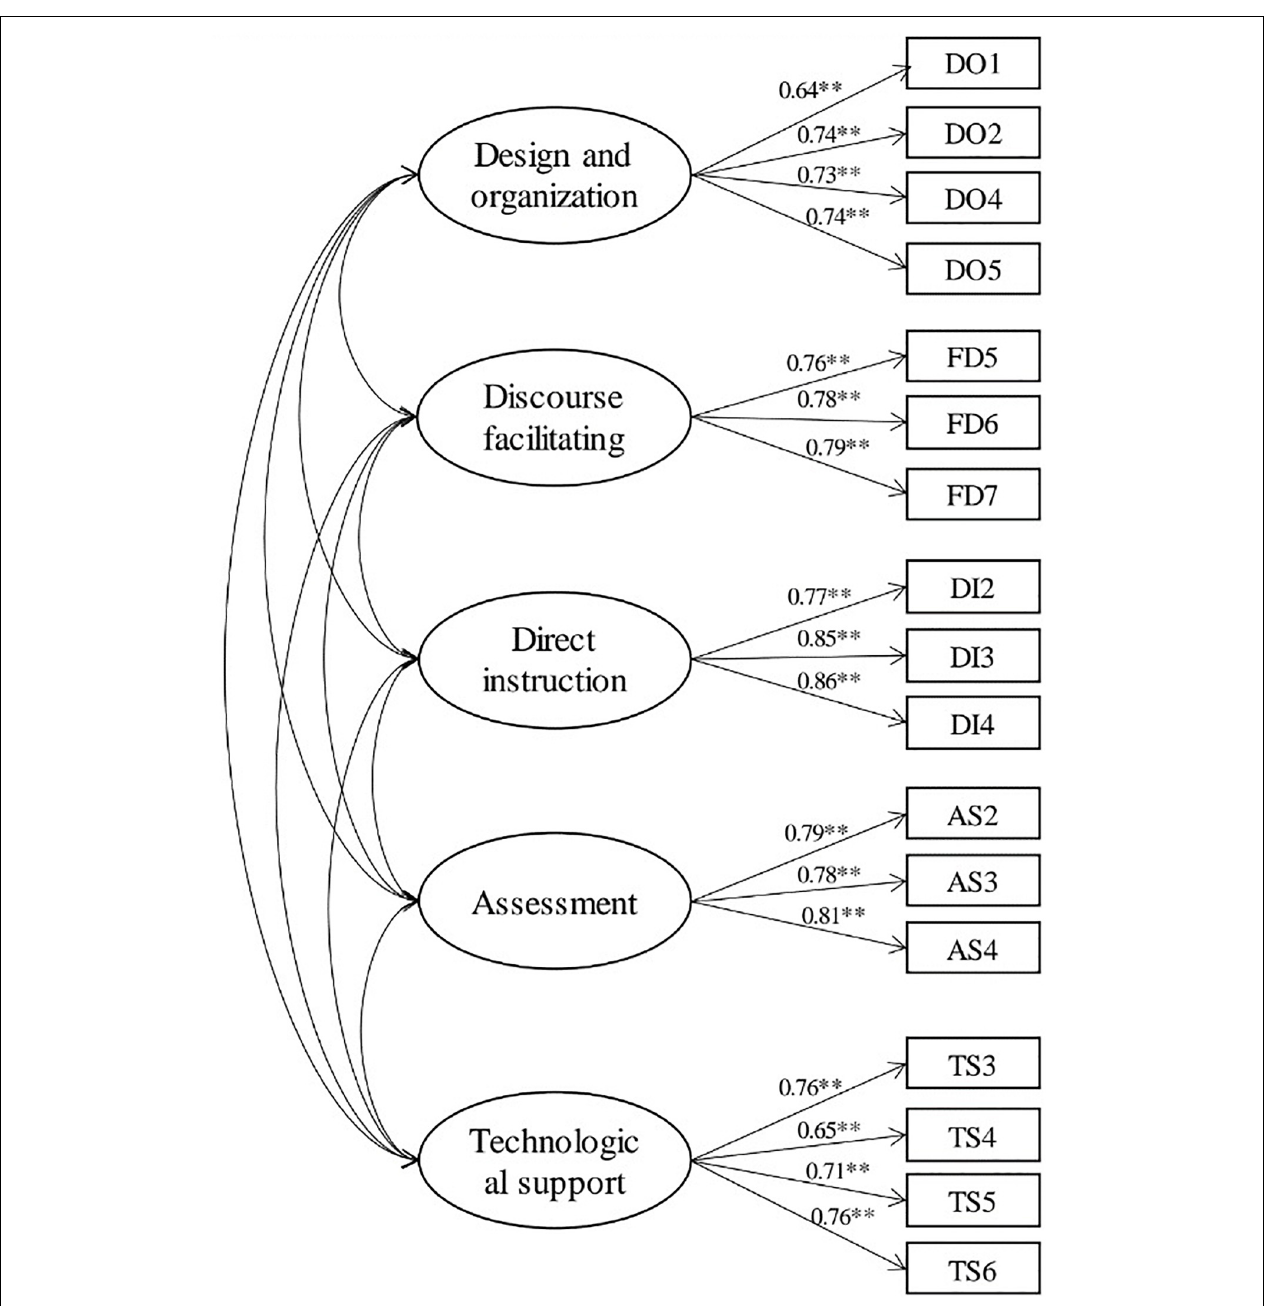
FIGURE 1 | First order confirmatory factor analysis model. ** p <